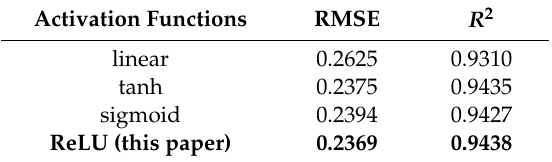
Table 1. Prediction performance of DNN models with di ff erent activation functions.